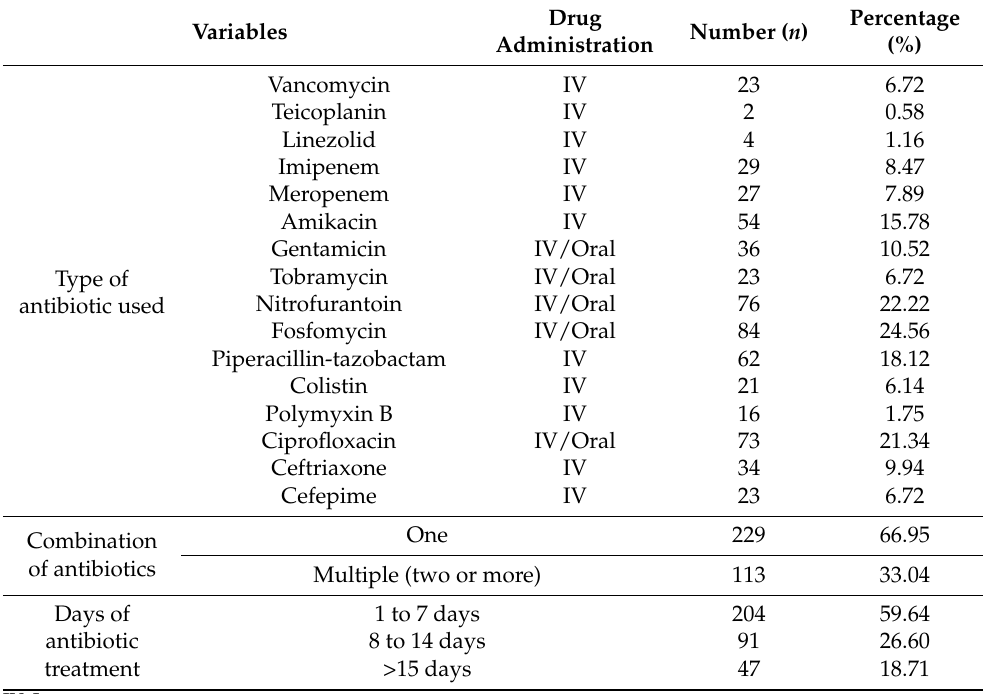
Figure 4. The antibiotic resistance patterns in ( A ) Acinetobacter baumannii, ( B ) Pseudomonas aeruginosa, ( C ) Stenotrophomonas maltophilia. In SICUs, different antibiotics were prescribed and given to patients with a different diagnosis, as shown in Table 3. Table 3. Clinical isolates from various samples and their prescribed antibiotics.